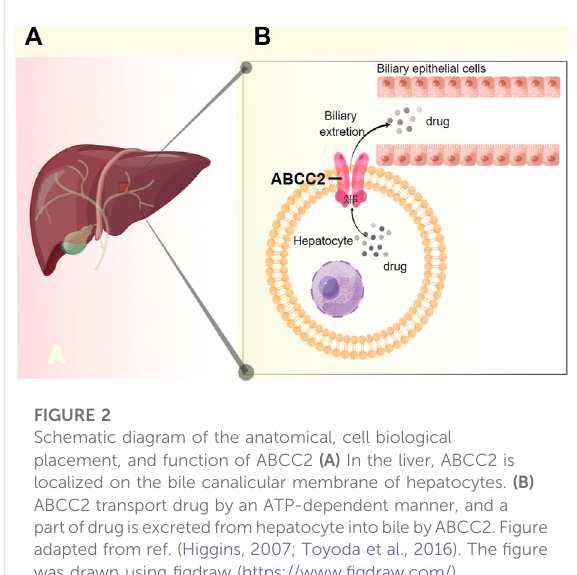
FIGURE 2 Schematic diagram of the anatomical, cell biological placement, and function of ABCC2 (A) In the liver, ABCC2 is localized on the bile canalicular membrane of hepatocytes. (B) ABCC2 transport drug by an ATP-dependent manner, and a partofdrugisexcretedfromhepatocyteintobilebyABCC2.Figure adapted from ref. (Higgins, 2007; Toyoda et al., 2016). The fi gure was drawn using fi gdraw (https://www. fi